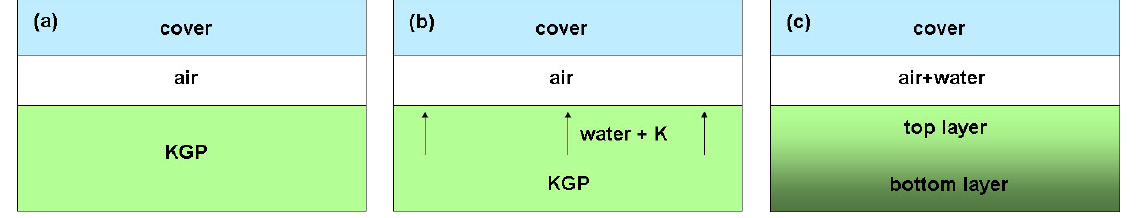
Figure 7. Schematic demonstration of the GP curing process. ( a ) before curing, ( b ) during the curing process, and ( c ) after curing process.